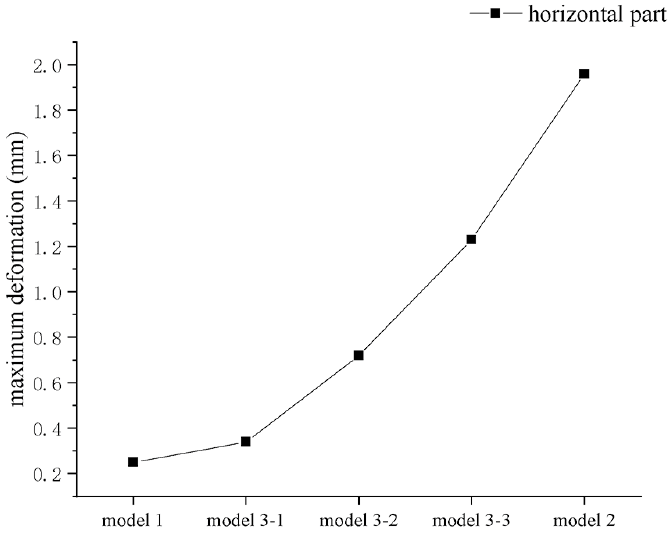
Figure 24. Maximum vertical displacements of the horizontal part of each model. For the four types of prefabricated cantilever components, it is shown that the maxi- mum vertical displacement values all meet the requirements of GB 50010-2010 [34] that the displacement limit is l0/250 (l0 is taken as the cantilever length L of the horizontal part of each component, see Table 1 for